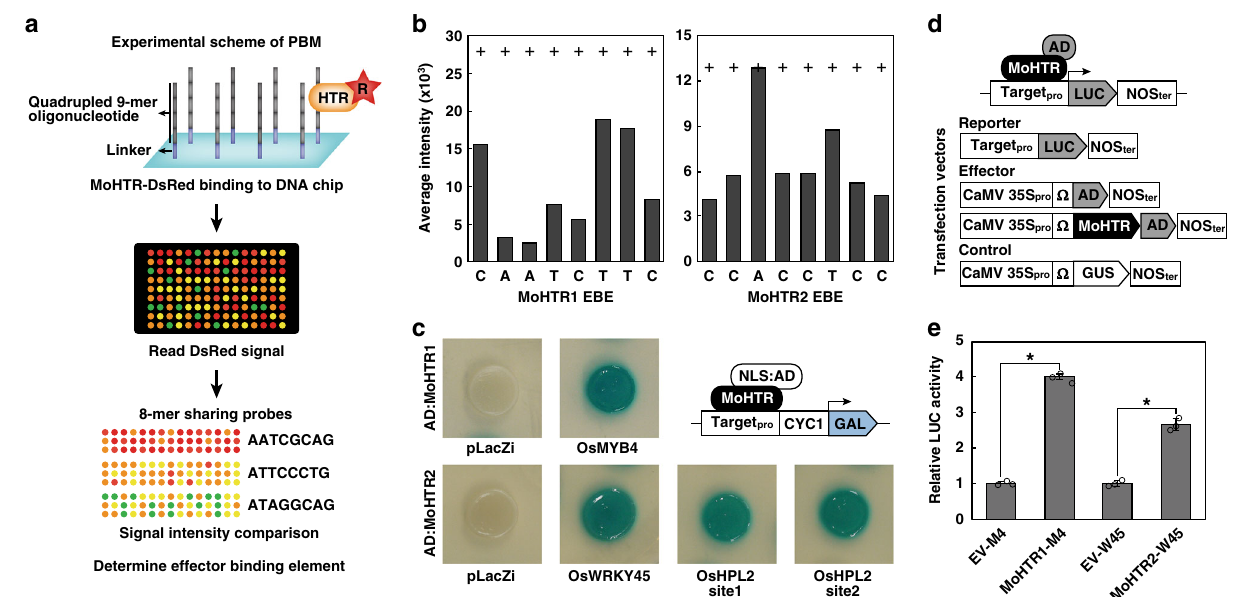
Fig. 3 Identi fi cation of effector binding elements targeted by MoHTR1 and MoHTR2. a Effector binding elements (EBEs) targeted by MoHTR1 and MoHTR2 were identi fi ed using a protein binding microarray. Each MoHTR- Δ sp:DsRed (R) protein produced using E . coli was applied to DNA chip containing quadrupled 9-mer nucleotides. The EBE for each protein was identi fi ed based on the fl uorescent intensity from the group of elements